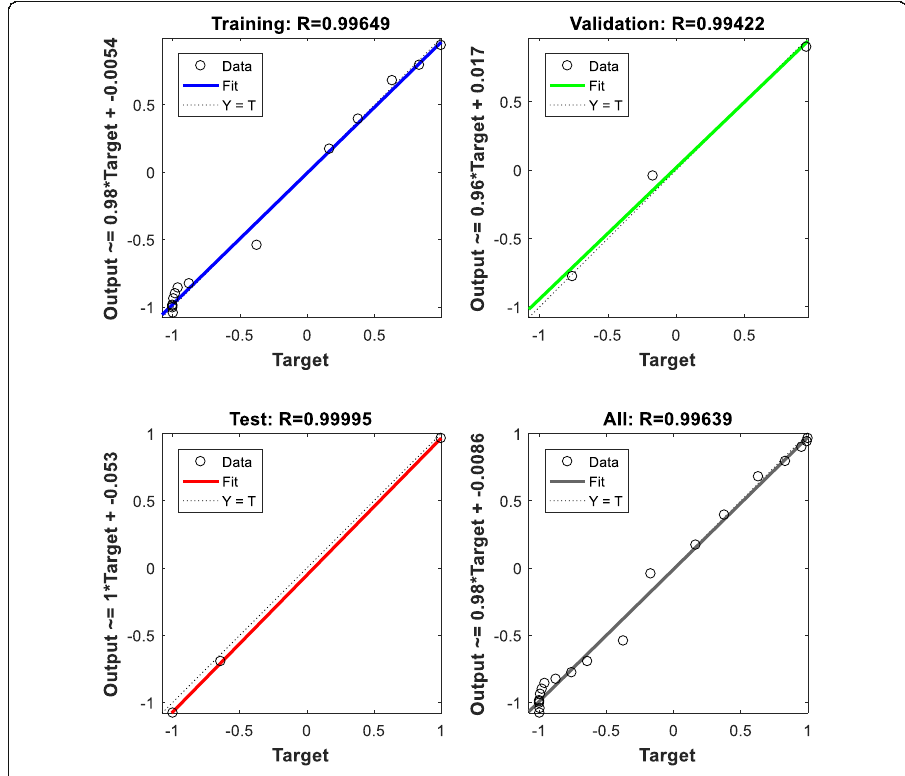
Fig. 6 Regression analysis curve of BP neural network